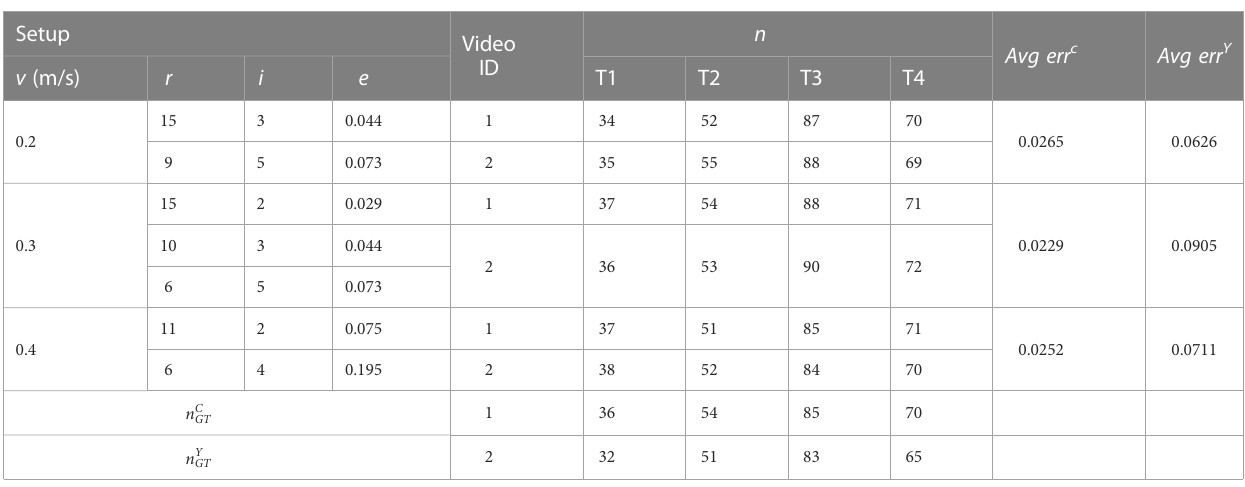
T1isthe fi rsttieroftheplantgrowingrowintheexperimental area.nistheresultoftheyieldmonitoring algorithm. n C GT isthenumber ofripestrawberryfruitinthedetectionresults. n Y GT isthe number of ripe strawberries in the raw video. err C is the relative error rate of fruit counting. err Y is the relative error rate of yield